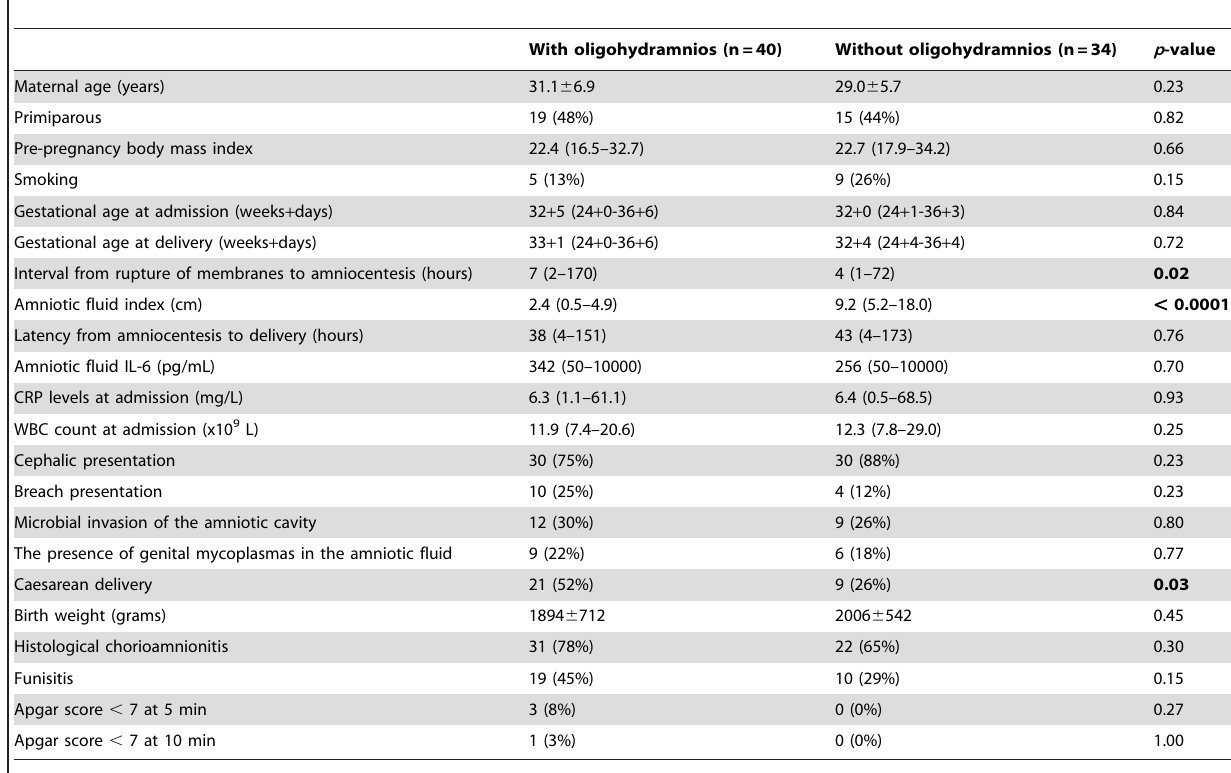
Table 1. Maternal and neonatal characteristics in the group of women with preterm prelabor rupture of membranes with respect to the presence and absence of